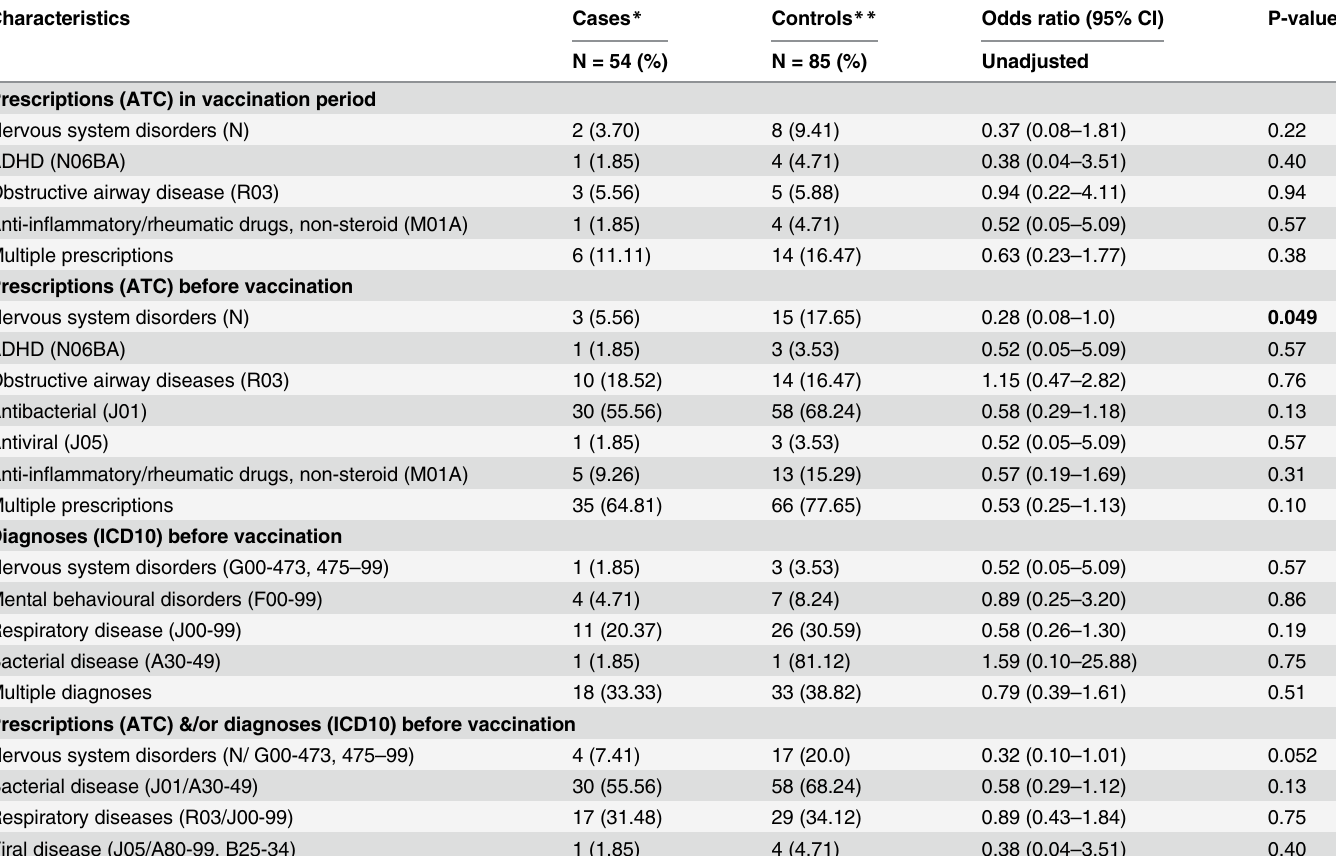
Table 3. Vaccinated-only analysis investigating prescription (ATC) history during the vaccination period and ever before A(H1N1)pdm09 vaccina- tion and diagnosis (ICD10) history ever before vaccination and prior to index on the risk of developing narcolepsy.